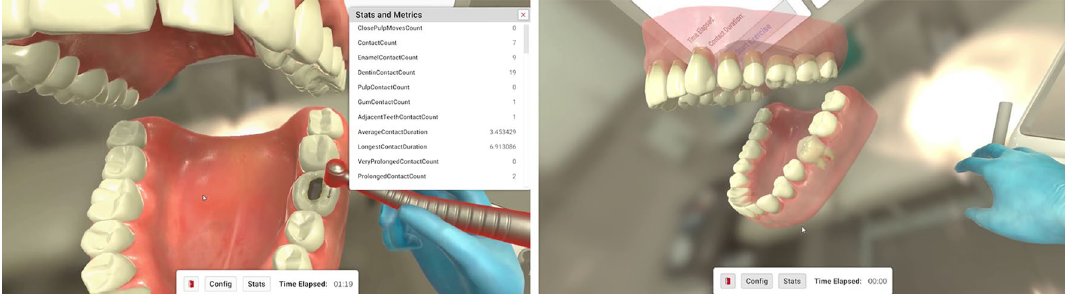
Figure 5. Over the duration of the exercise an array of metrics is collected and saved for analysis. These metrics can be monitored in real time by an examiner on the computer screen. The gums along with every layer of the tooth tissue can be set to translucent or invisible allowing users to easily view inner structures like the dentine and pulp that would otherwise always be